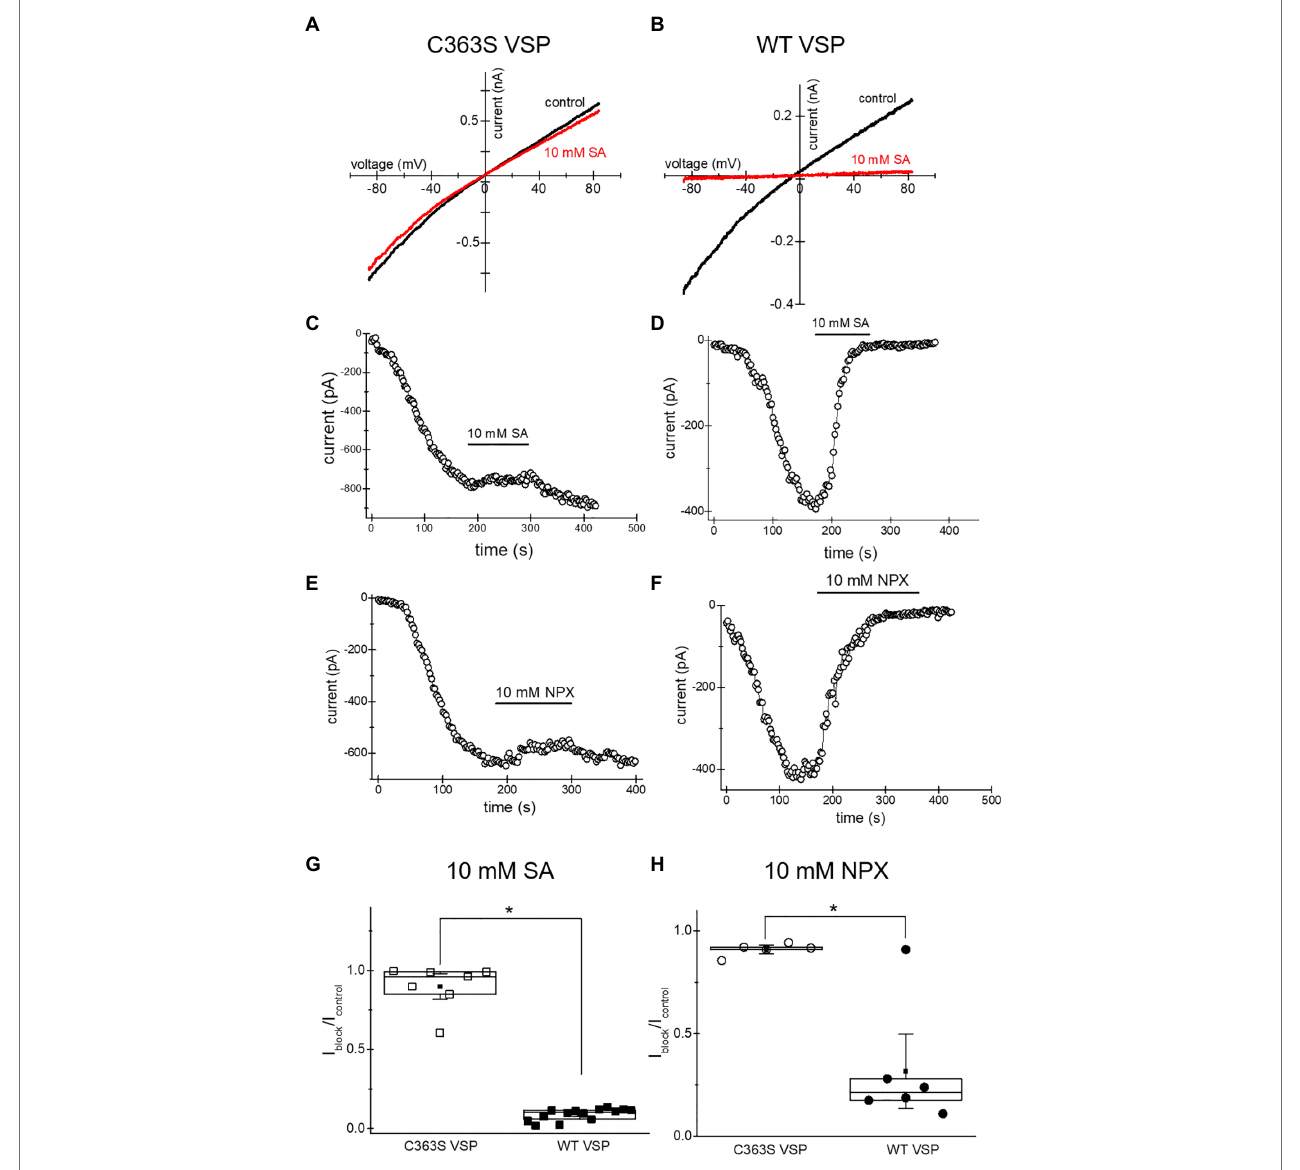
FIGURE 6 | Salicylate effect on TRPM7 current in HEK293 cells expressing WT CiVSP and its inactive C363S variant. (A,B) Endogenous TRPM7 monovalent I–V relations in the absence and presence of 10 mM salicylate. HEK293 cells were transfected with C363S VSP (A) and WT VSP (B) . (C,D) Time courses of 10 mM salicylate effect in HEK cells expressing C363S and WT VSP. (E,F) Time courses of 10 mM naproxen effect in HEK cells overexpressing C363S and WT VSP. (G,H) I block /I control ratios measured for 10 mM salicylate (G) and 10 mM naproxen (H) . Current amplitude was measured at the 40th (G) and 35th (H) ramp during drug application (I block ) and divided by the amplitude immediately before drug application (I control ). The current amplitudes were measured at − 85 mV. The internal and external recording solutions were Cs + based. * p < 0.05, Student’s two-sample t